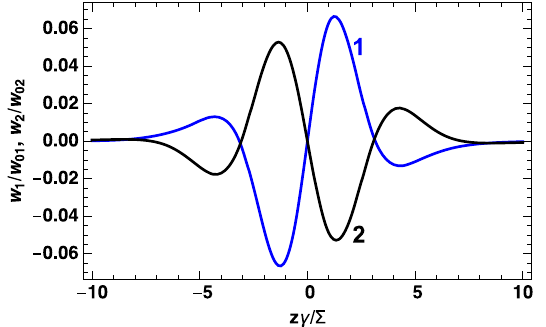
FIG. 9. Plot of normalized wake functions for one (1, blue curve) and two (2, black curve) amplification sections. These wakes are odd functions of coordinate z .